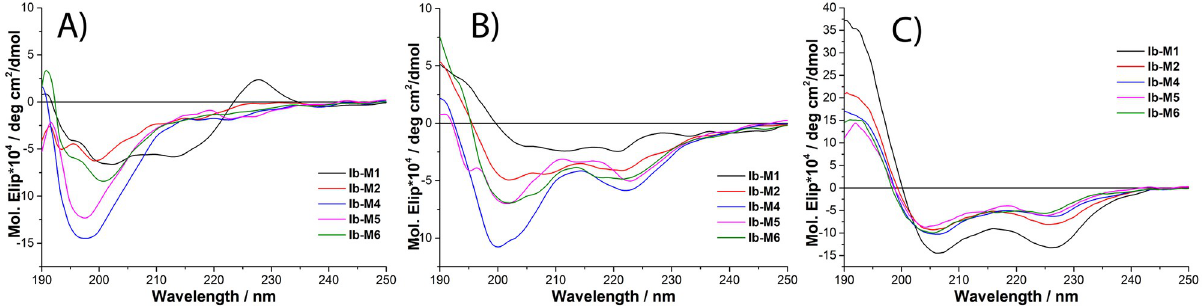
Fig 1. Circular dichroism spectrum of Ib-M peptides in Tris-HCl buffer (A), TFE (B) and SDS (C).